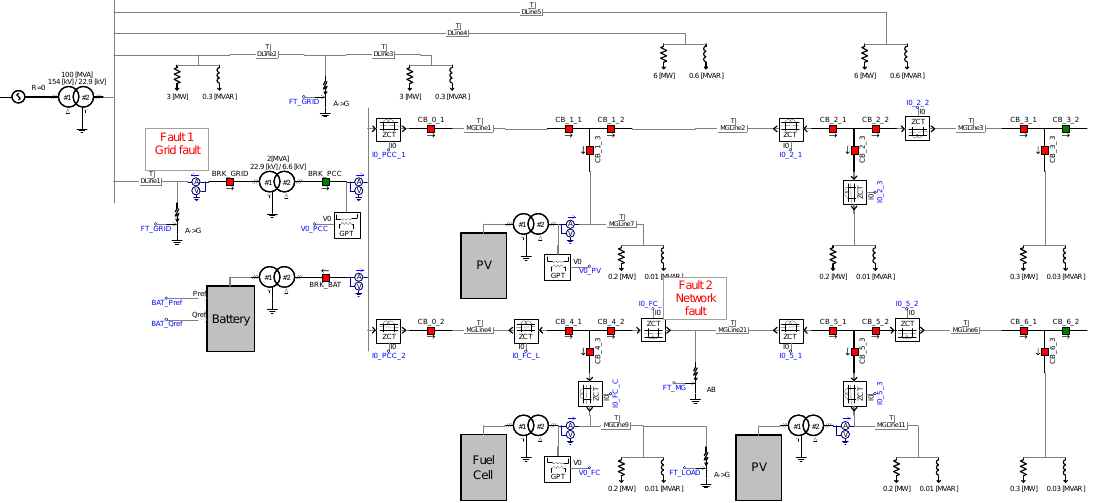
Figure 13. The Power System Computer Aided Design (PSCAD)/Electromagnetic Transients including DC (EMTDC) model of the low-inertia microgrid.